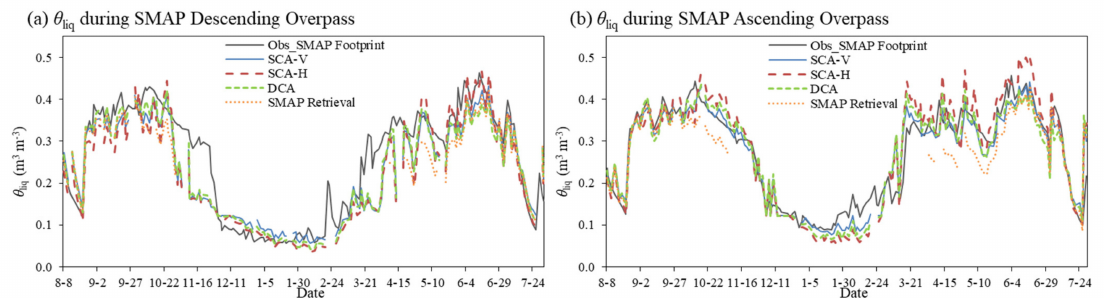
Figure 8. Time series of average θ liq measurements of SMAP footprint and retrievals obtained by the SCA-V, SCA-H and DCA algorithms based on the SMAP measured T B p for the ( a ) descending and ( b ) ascending overpasses between August 2016 and July 2017. The θ liq retrieval derived from the SMAP SM product is also